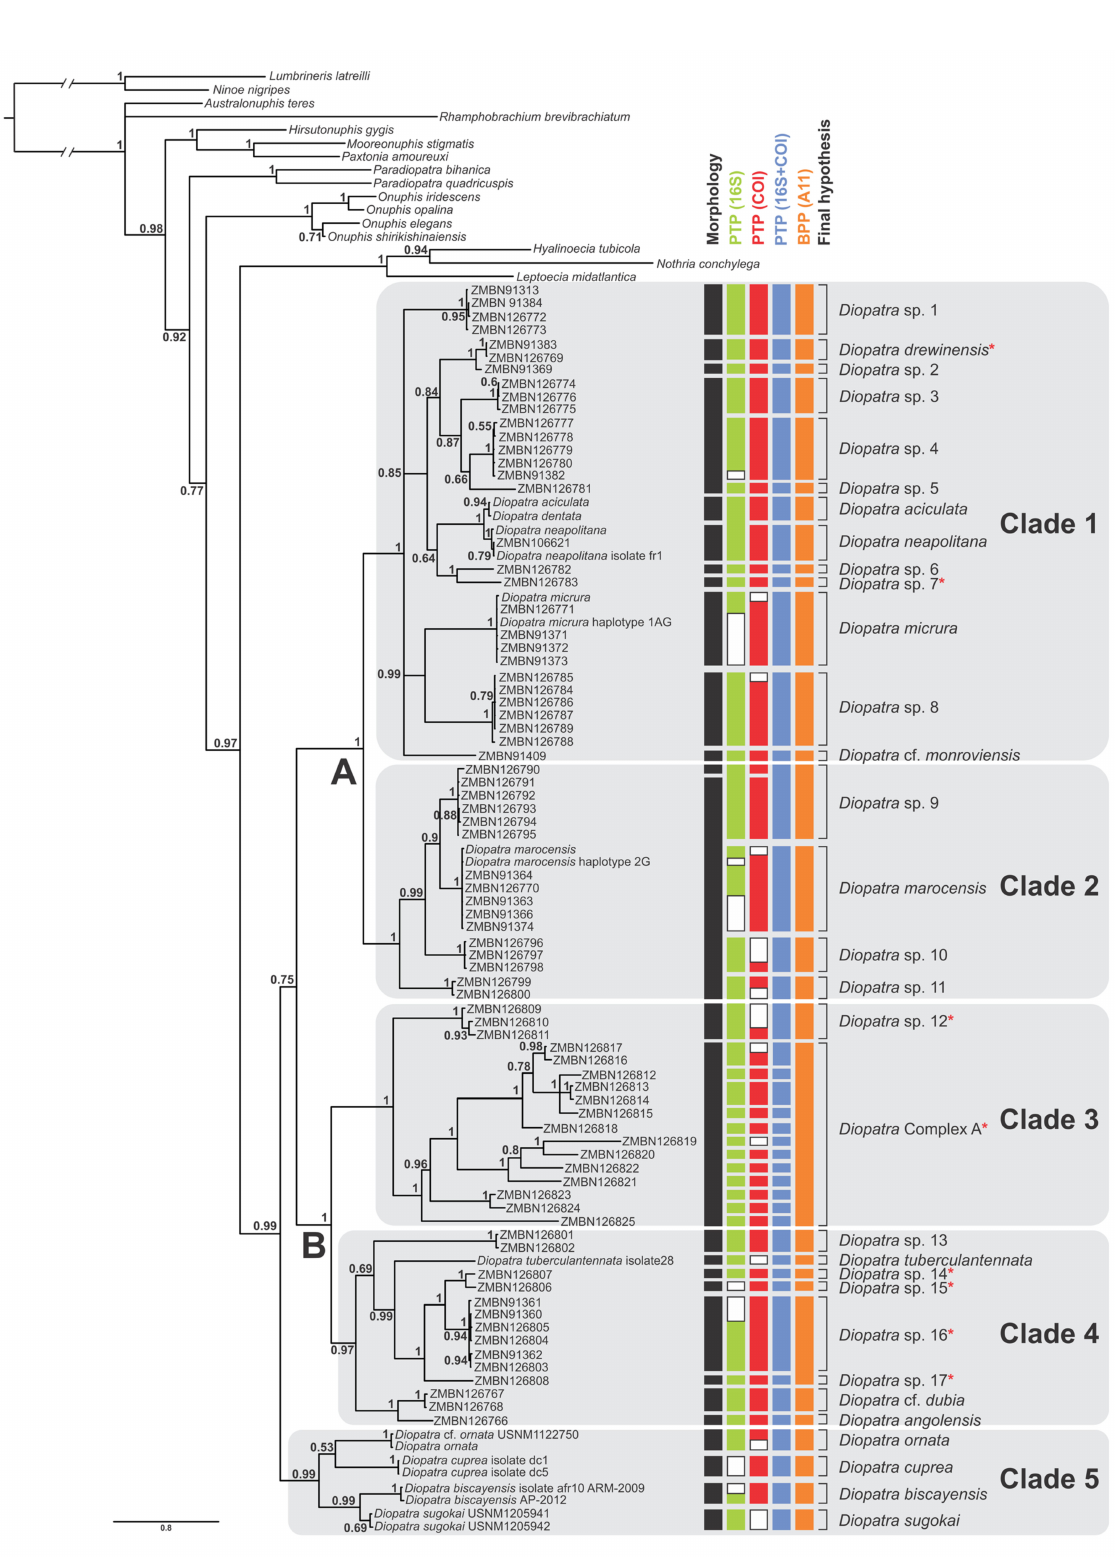
Figure 1. Consensus tree from the Bayesian analysis of the combined COI, 16S and 28S dataset; numbers on nodes indicate Bayesian posterior probabilities; capital letters and clades 1–5 correspond with the clades discussed in the text. Red asterisks indicate species or complexes lacking peristomial cirri, as in the former Epidiopatra . Species delimitation results inferred by morphology and DNA- based methods are indicated right to the consensus tree; bPTP was applied separately to the gene trees (COI, 16S and COI+16S treated as a single locus); BPP was based on three loci. White bars indicate missing